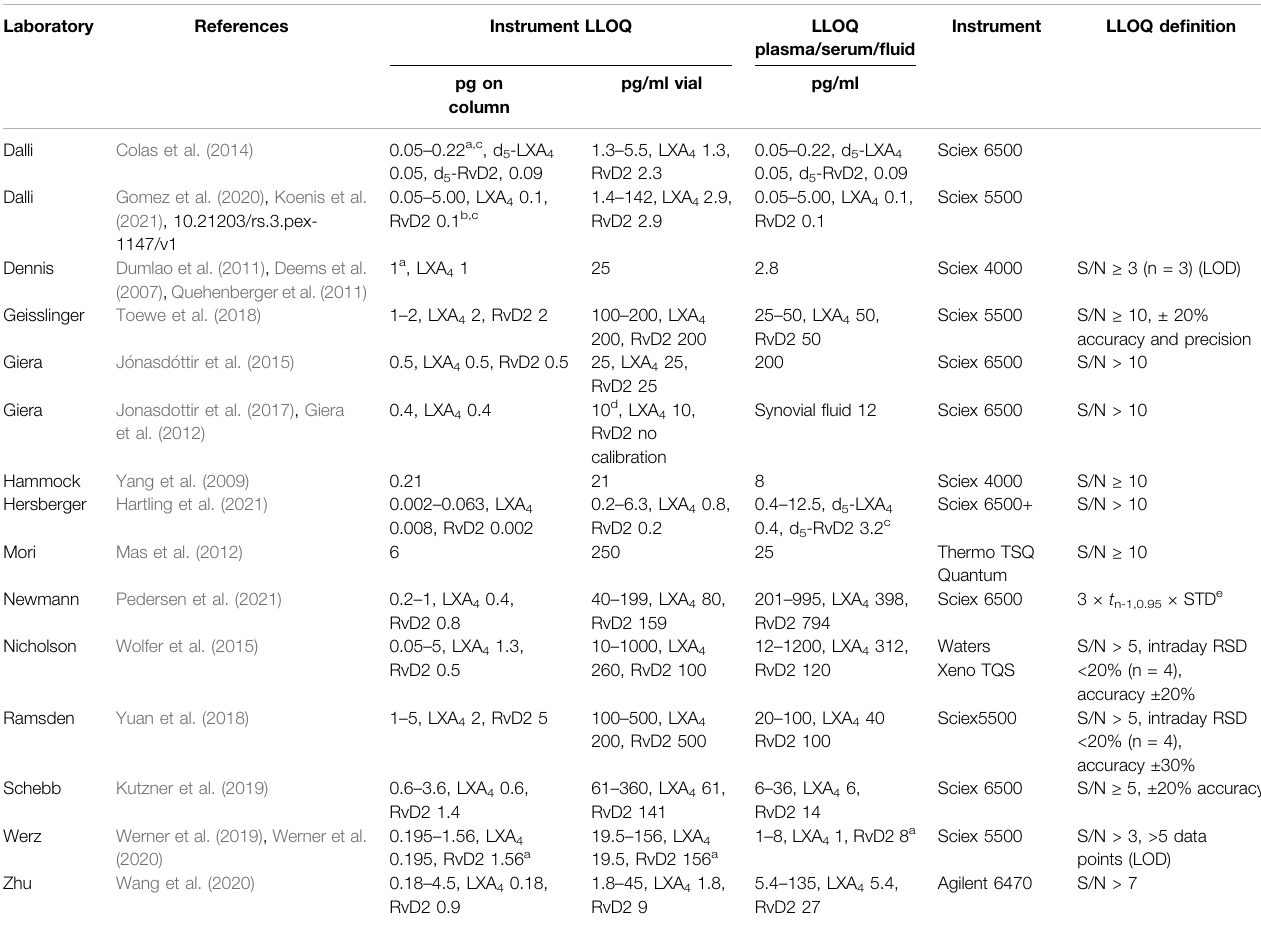
TABLE 2 | Sensitivity of state-of-the-art analysis of SPMs using